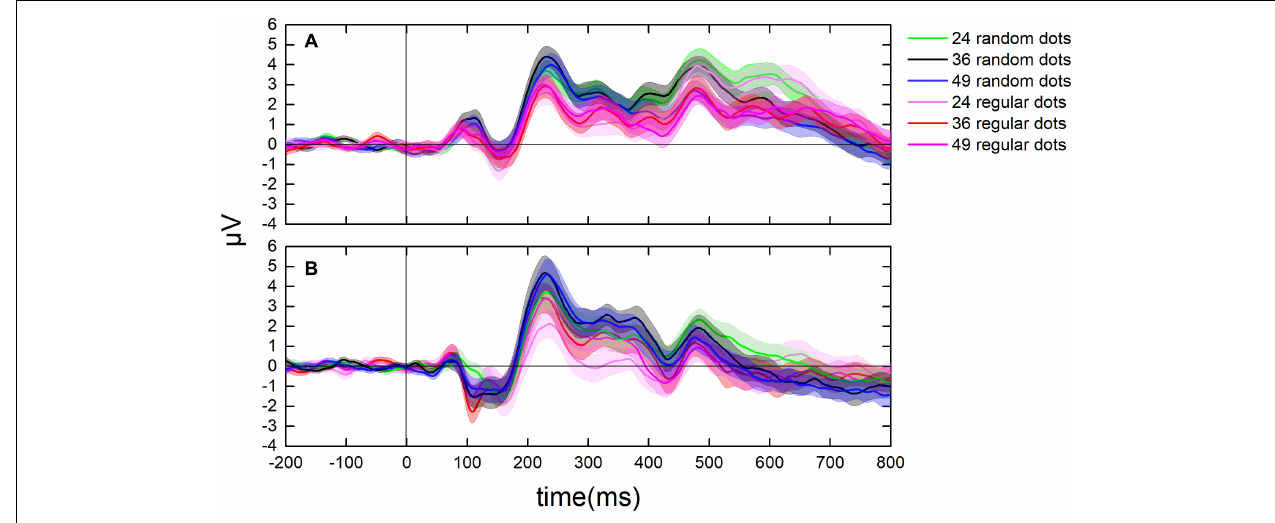
FIGURE 5 | Dynamic change of ERPs in the parietal and the occipital lobes. (A) The average value of ERPs of participants in the parietal lobe from 200 ms before to 800 ms after each test. (B) The ERPs in the occipital lobe from 200 ms before to 800 ms after each test. Curves in cool colors denote the ERPs when randomly distributed tests were presented, whereas curves in warm colors stand for the ERPs when regularly distributed tests were presented.